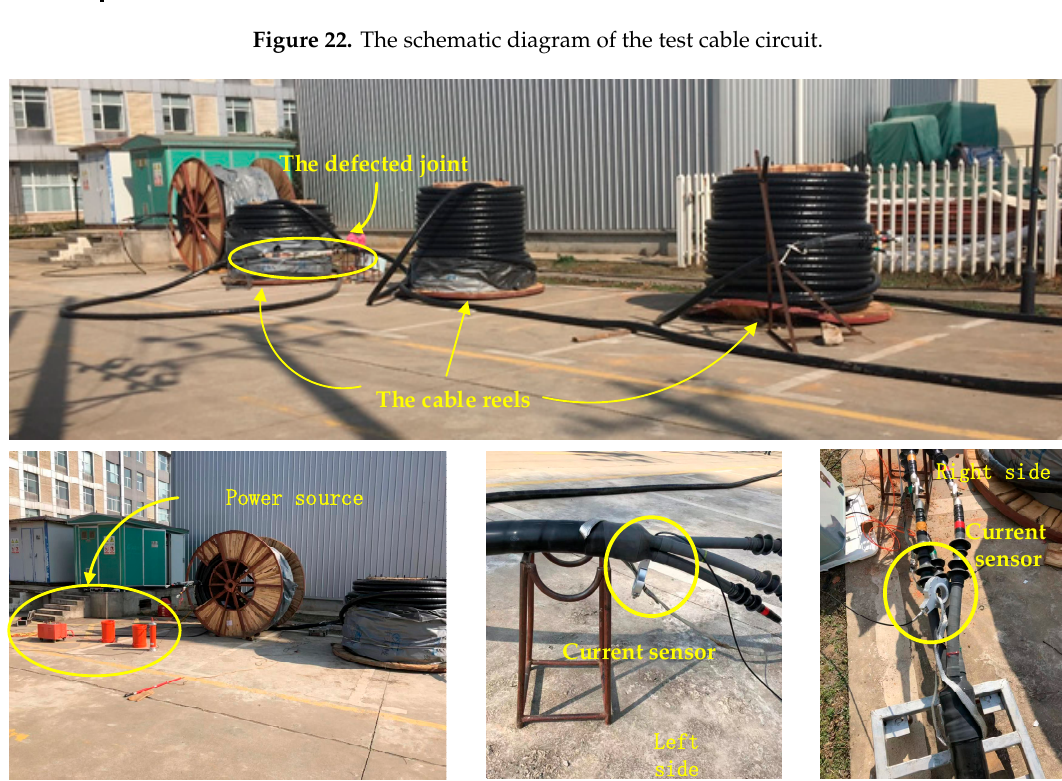
Figure 23. The on-site photos of the test MV (medium voltage) cable circuit.